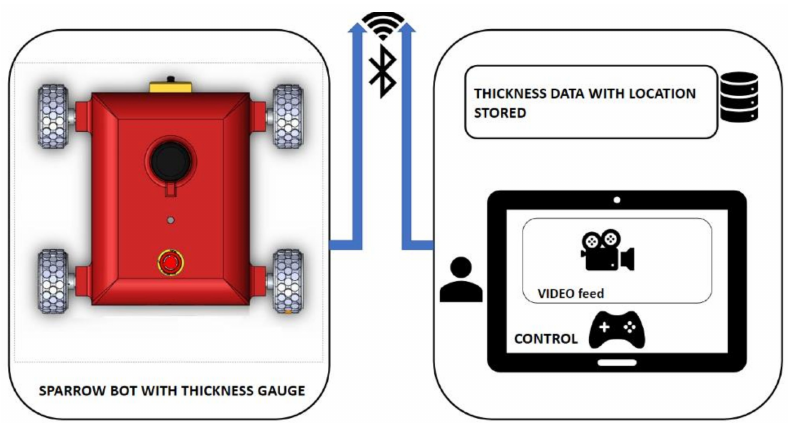
Figure 29. An overview of Sparrow, a robotic system [135].